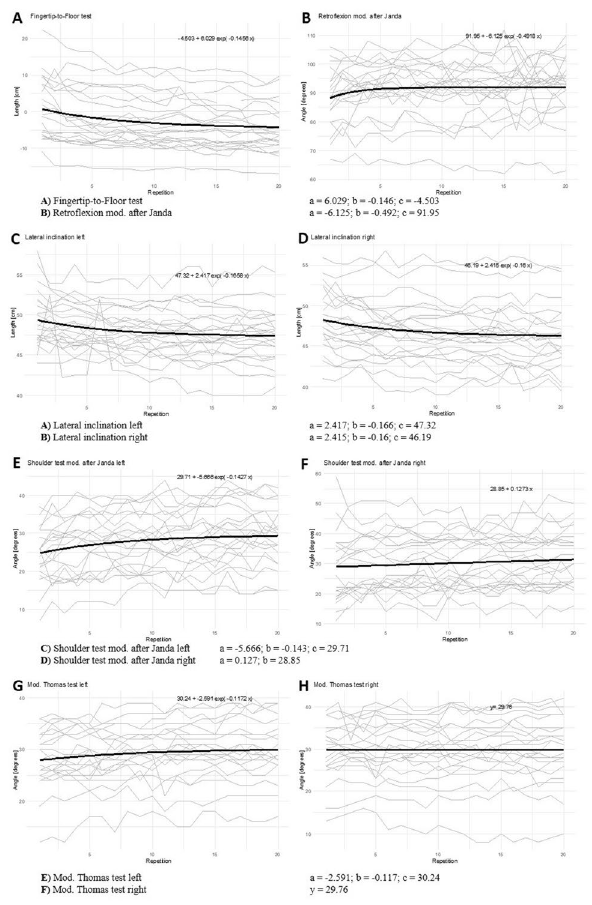
Figure 2. Non-linear regression for FtF, RF, LI, ST left and TT left. Linear regression for ST right and TT right. Parameters of the function are shown below.